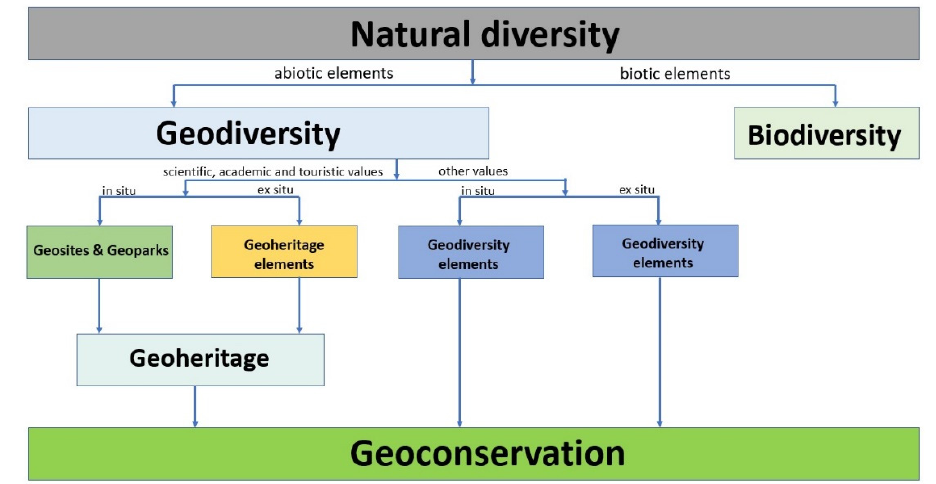
Figure 1. Conceptual framework of geodiversity, geological heritage, and geoconservation. Modified from [22].